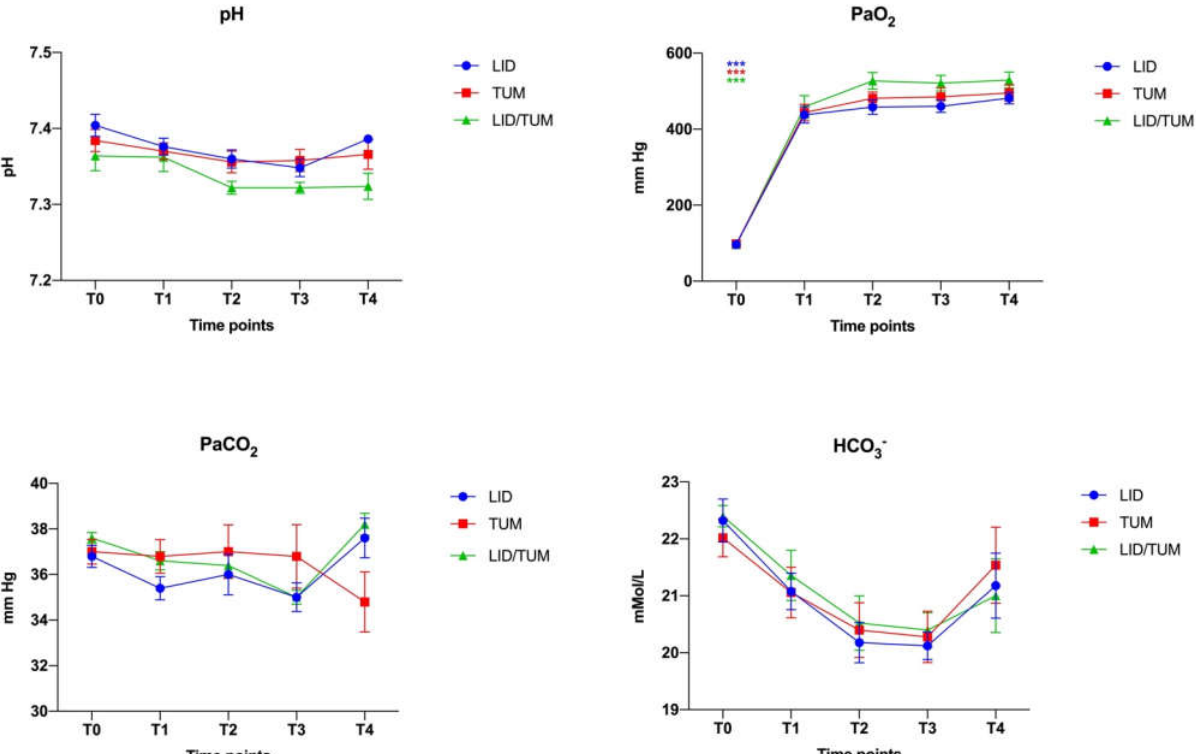
Figure 5. Mean values ± standard error of arterial blood pH, arterial oxygen tension (PaO 2 ) arterial carbon dioxide tension (PaCO 2 ) and bicarbonate concentration (HCO 3 − ) during anesthesia in the three groups. Groups, LID: Group Lidocaine; TUM: Group Tumescent anesthesia; LID/TUM: Group Lidocaine/Tumescent anesthesia. Time points, T0: immediately after the introduction of the arterial catheter; T1: immediately after the start of the surgery; T2: 15 min after the start of surgery; T3: 30 min after the start of surgery; T4: 40 min after the start of surgery. Asteriks indicate significant differences between groups: ***: p < 0.001.